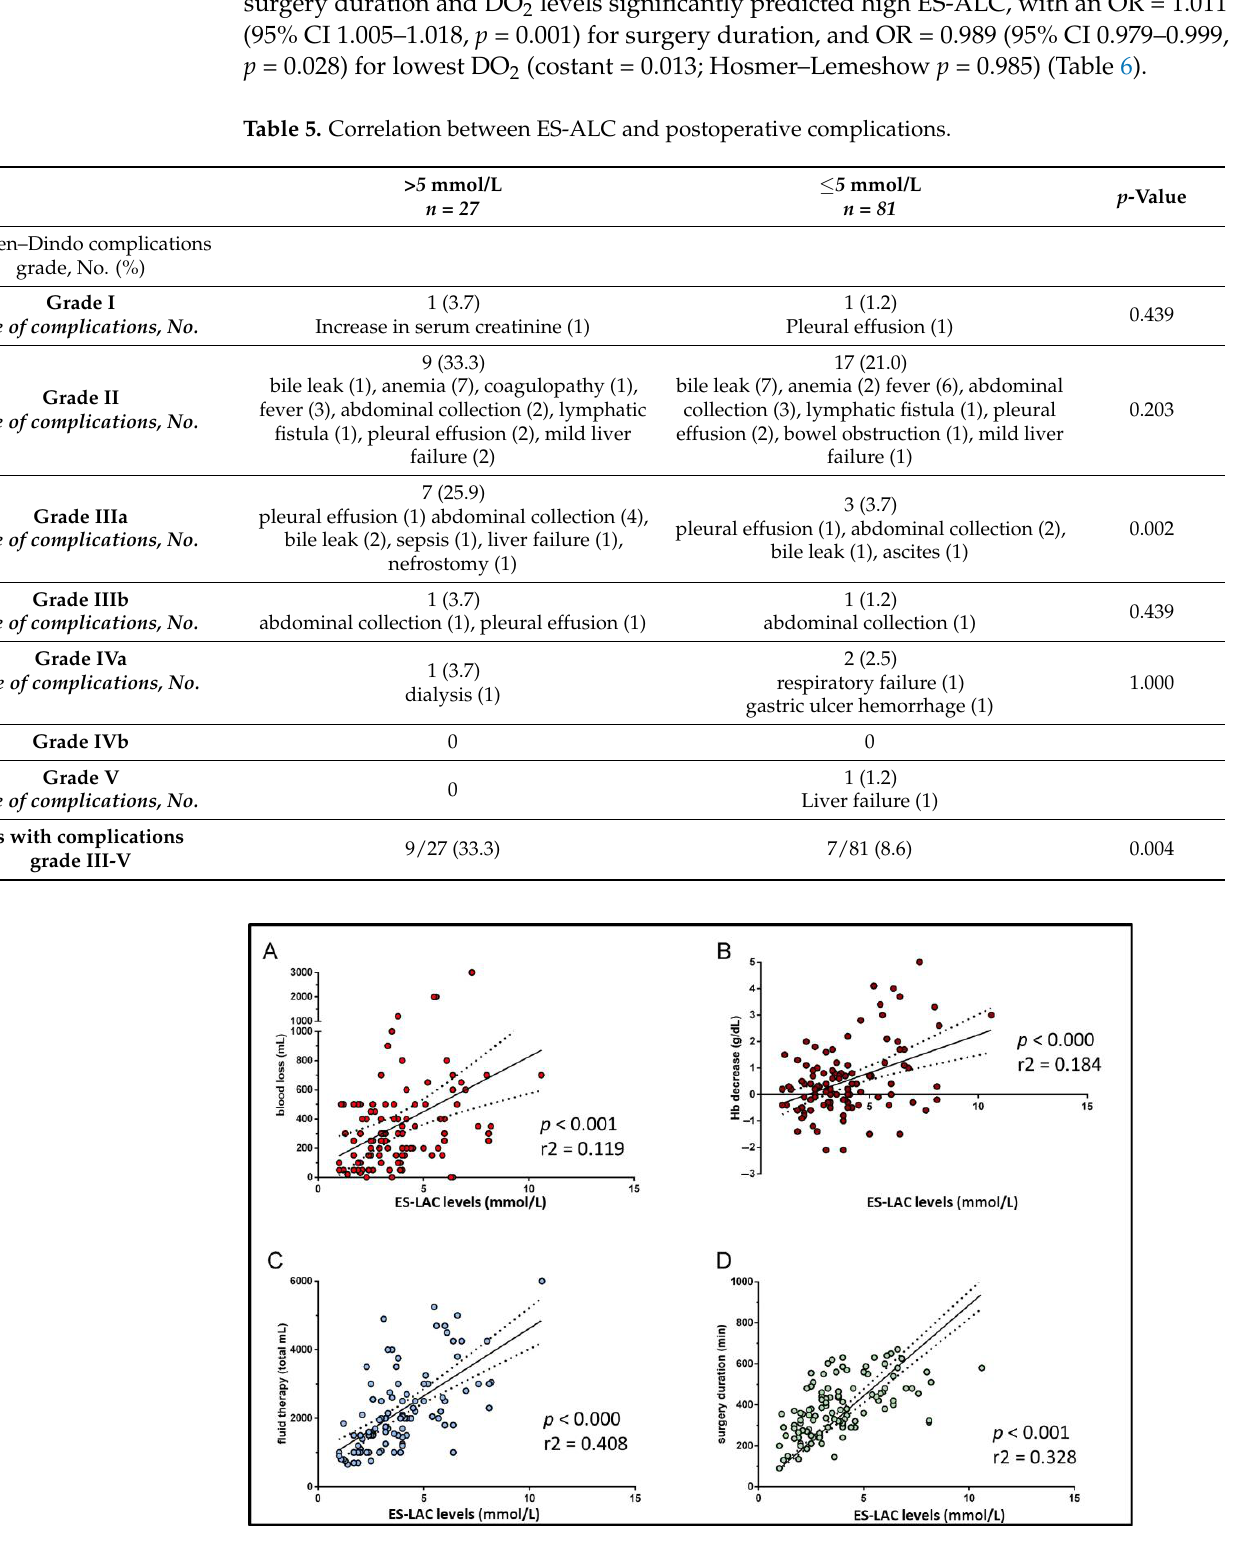
Figure 2. Linear regression analysis pairing lactate levels with drop of blood losses ( A ), Hb concen- tration ( B ), fluid administration ( C ), and surgery duration ( D ).